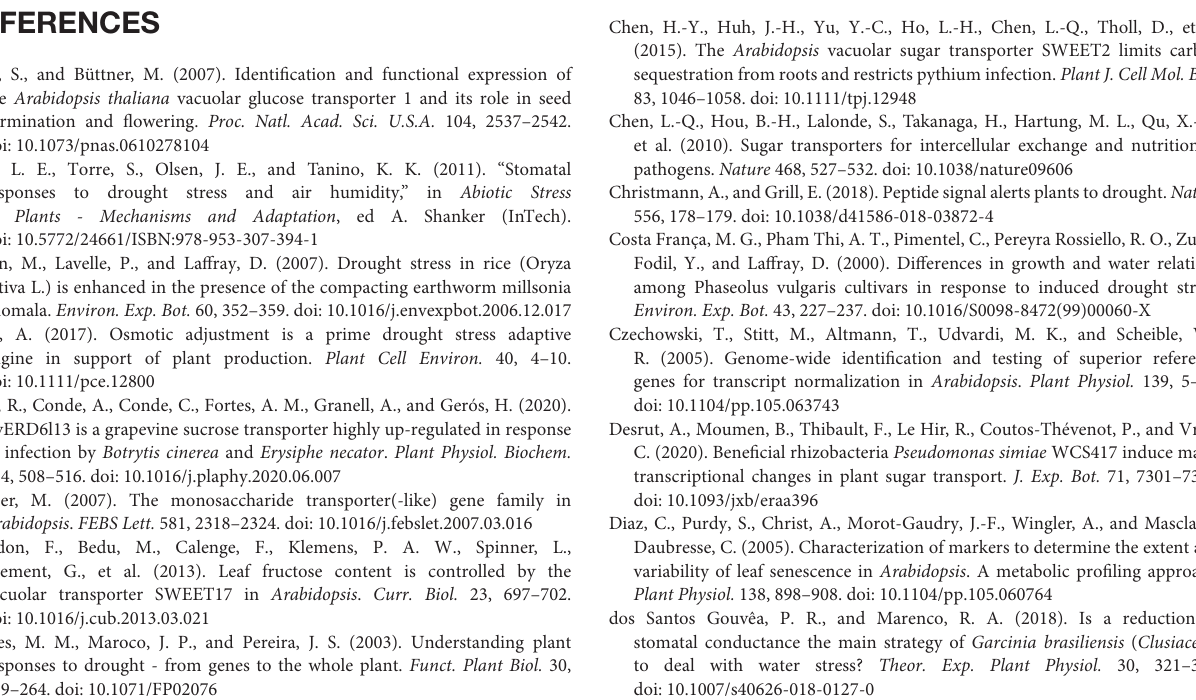
Supplementary Figure 5 | Characterization of the effect of water deficiency on the Arabidopsis A. thaliana Col-0 and the atesl mutants ( 1.02/erdl6 , atesl3.03